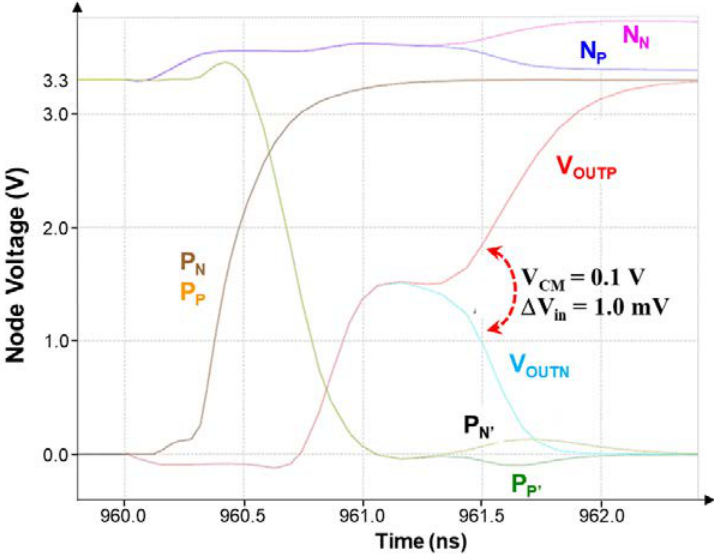
Figure 11. Simulation waveforms of the proposed comparator with V CM = 0.1 V and ∆ V in = 1.0 mV. If the common-mode voltage V CM is set to 3.3 V, two NMOSs, MN11 and MN12, turn on and two PMOSs, MP11, and MP12, turn off, simultaneously. Then four node voltages, N P , N N , P P , and P N , were pushed down to ground and two node voltages, P N’ and P P’ , were pulled up to V DD by passing through inverters. As the differential input voltage ∆ V in of 1.0 mV, the discharge rate are different at nodes, N N , N P , P N’ , and P P’ . Thus the differential output voltages, V OUTP and V OUTN , were connected to V DD (3.3 V) and ground (0 V), respectively, by passing through the latch stage with cross-connected inverter